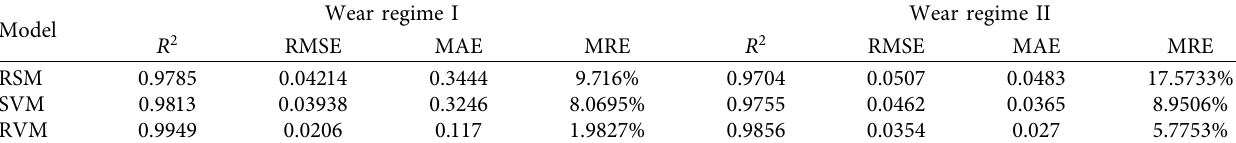
Table 3: Prediction performance indexes of different prediction models based on field measurements.